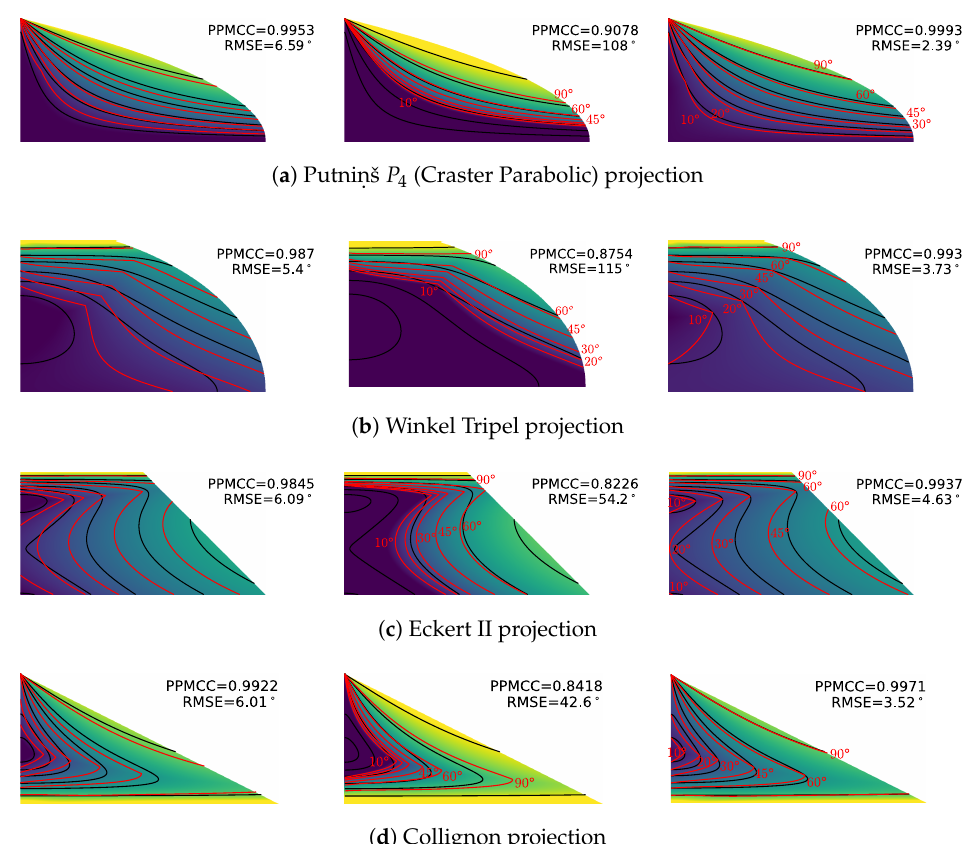
Figure 9. Distribution and contours (in red) of FWD–GCA metric based on linear regression with different regression